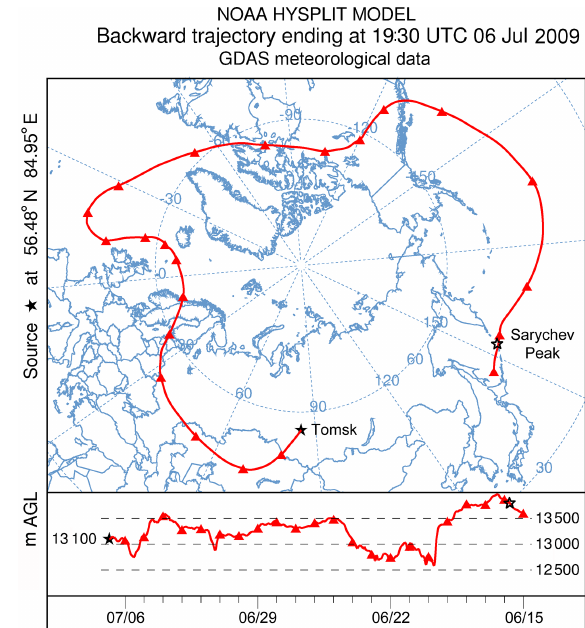
Figure 9. Air mass backward trajectory started from an altitude of ∼ 13.1kma.s.l. over Tomsk on 7 July at 02:30LT (6 July, 19:30UTC).